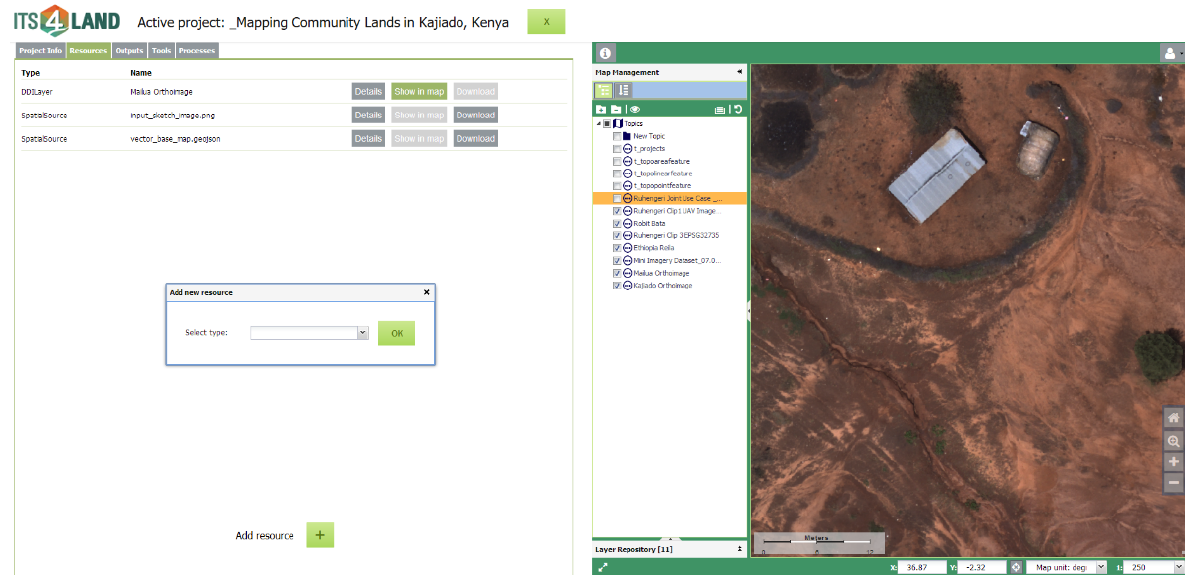
Figure 4. Client Web Application—Adding Resources.